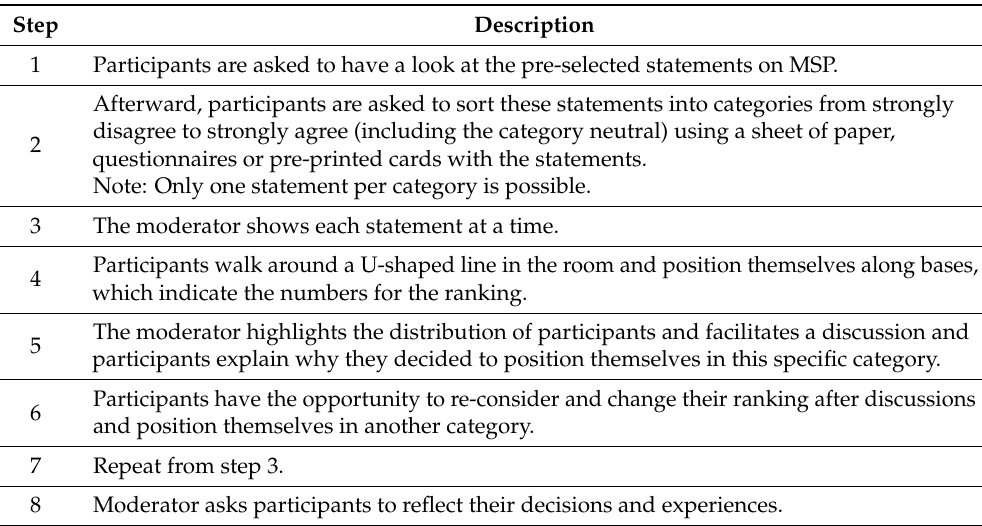
Table 3. ‘Living Q’ rules of the game.